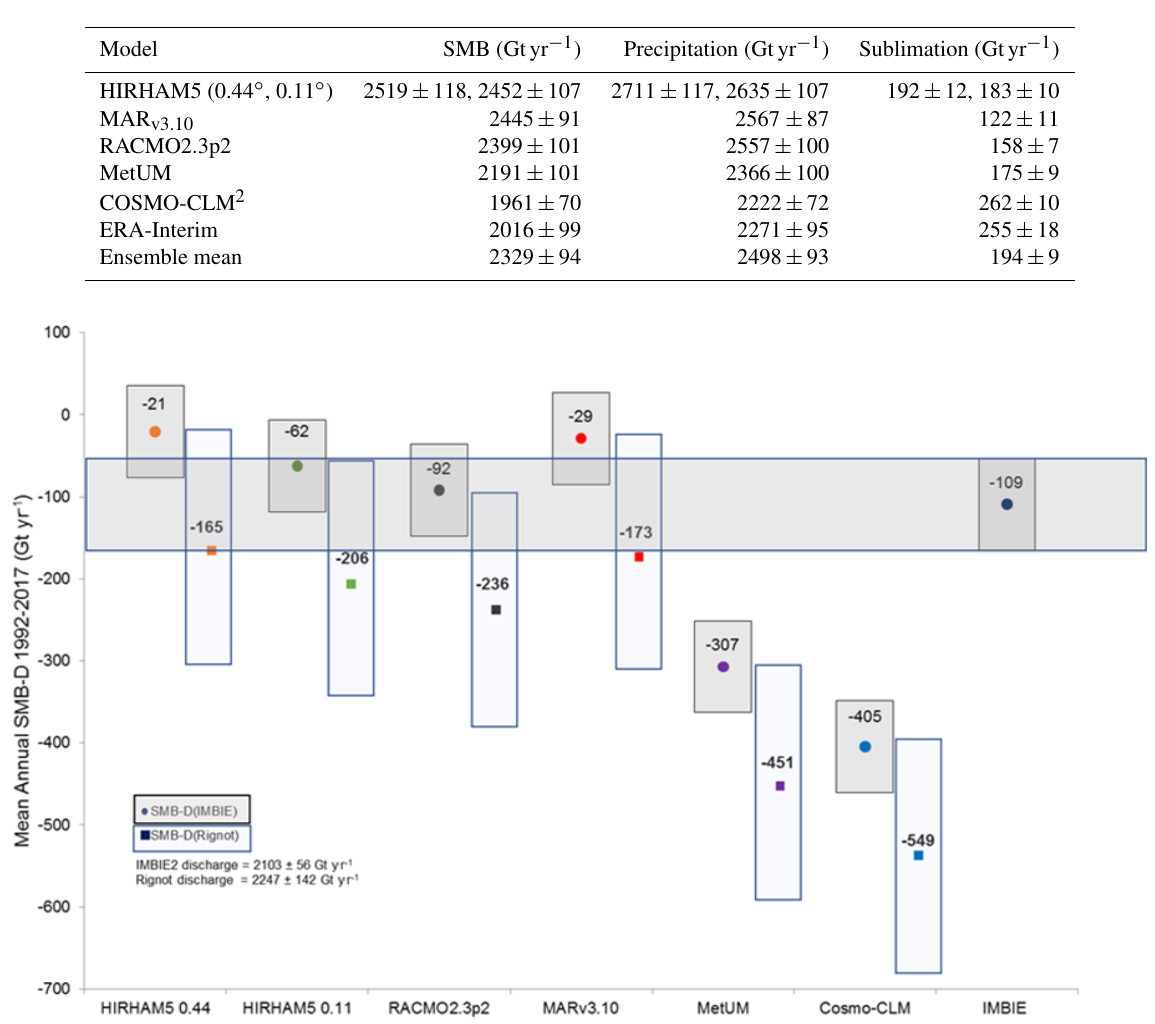
Figure 10. Modelled SMB minus discharge calculated from IMBIE2 results (Shepherd et al., 2020) (filled circles indicate mean; light- grey box indicates IMBIE2 uncertainty range of ± 56Gtyr − 1 ) and Rignot et al. (2019) (mean showed in filled square; uncertainty range of 142Gtyr − 1 shown by narrow shaded blue box). The range for the Rignot discharge is taken from Table 1 in Rignot et al. (2019). We assume that the same uncertainty range for the period 2009 to 2017 is applicable over the longer 1992–2017 period. The total mass budget estimated by IMBIE2 is also shown by the horizontal shaded dark-grey box for ease of comparison. Numbers are mean annual SMB-D for the 1992–2017 IMBIE period for each